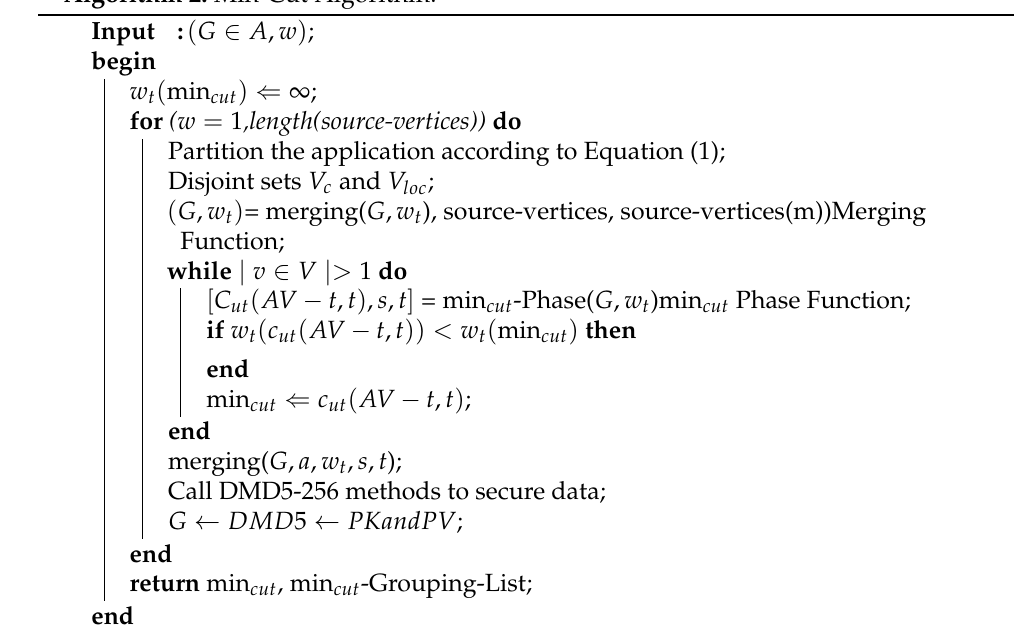
Algorithm 2: Min-Cut